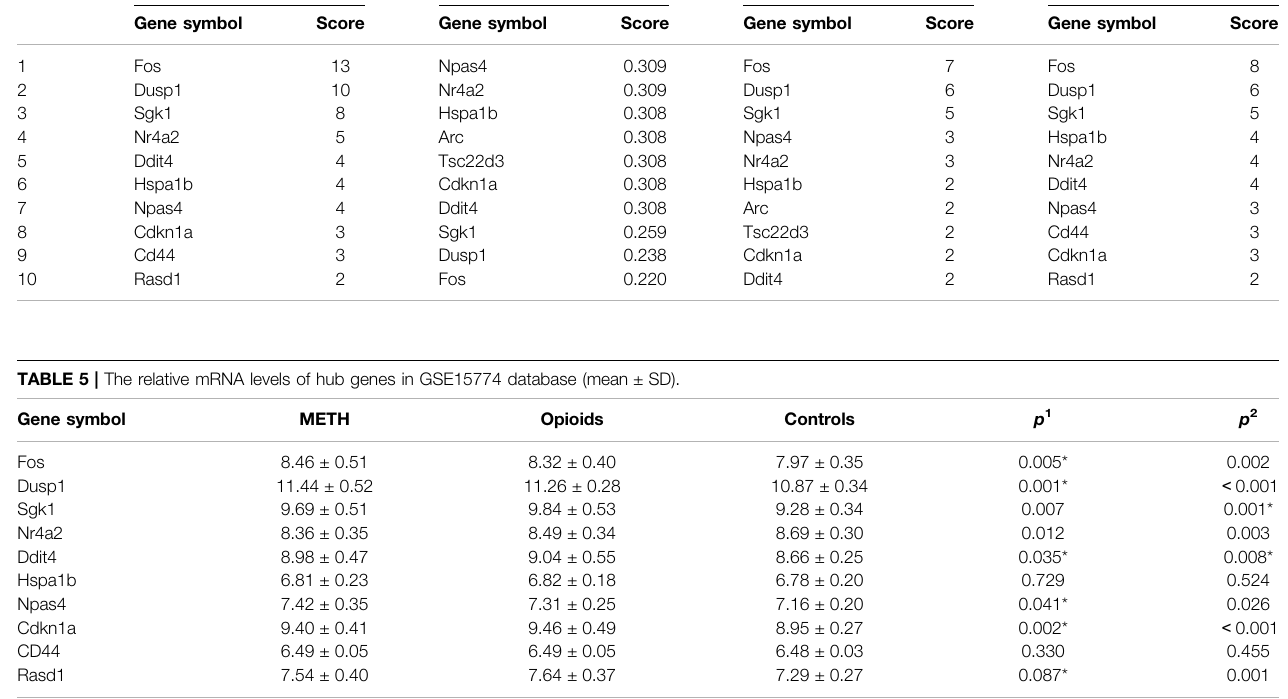
TABLE 4 | Maximal clique centrality (MCC), density of maximum neighborhood component (DMNC), maximum neighborhood component (MNC), and degree score of the top 10 hub genes by the CytoHubba plugin in Cytoscape Software. Rank MCC Gene symbol